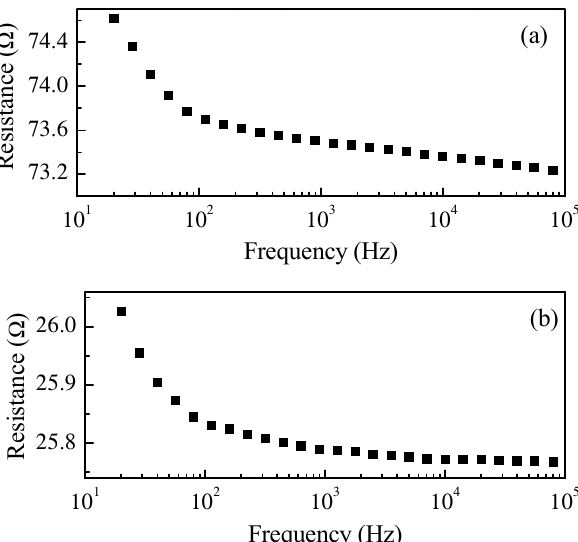
Figure 6. Current–voltage plots of PPY:DBSA and PPy-GNP:DBSA films.